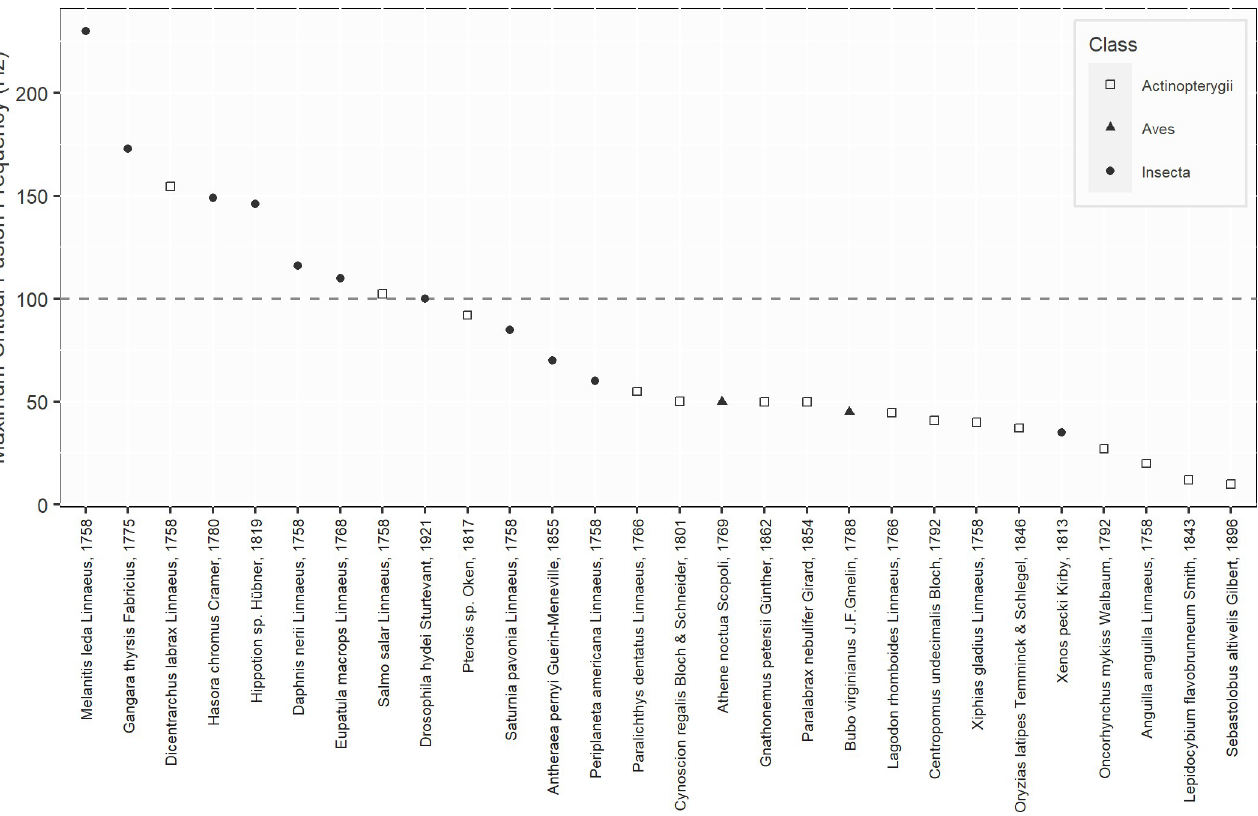
Fig 2. Distribution of maximum Critical Fusion Frequencies (CFF). Only species living under low and variable light exposure levels in Actinopterygii, Aves, and Insecta, the three classes that had species with CFF higher than 100 Hz, are represented. The dashed line represents the flicker frequency of a lamp on a 50 Hz electrical supply—i.e. 100